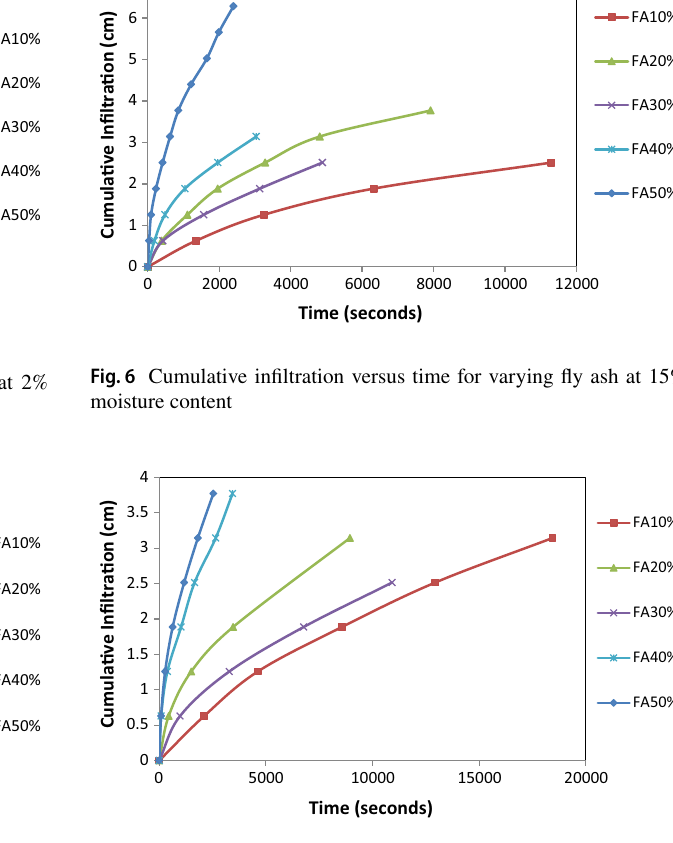
Fig. 7 Cumulative infiltration versus time for varying fly ash at 20% moisture